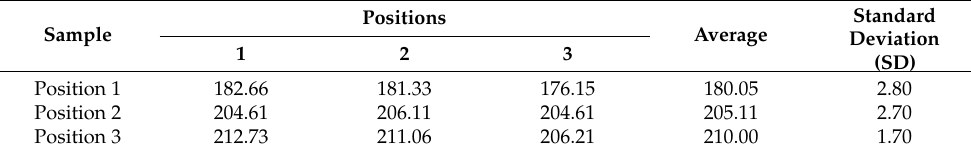
Table 5. Results of the Vickers microhardness test for hot-wire plasma